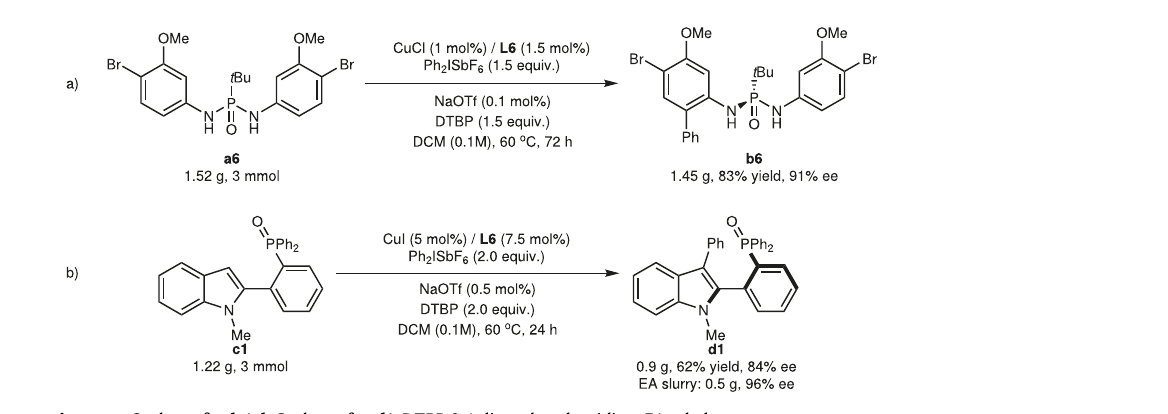
Fig. 6 | Scale-up experiment. a Scale up for b6 . b Scale up for d1 . DTBP 2,6-di- tert -butylpyridine, EA ethyl